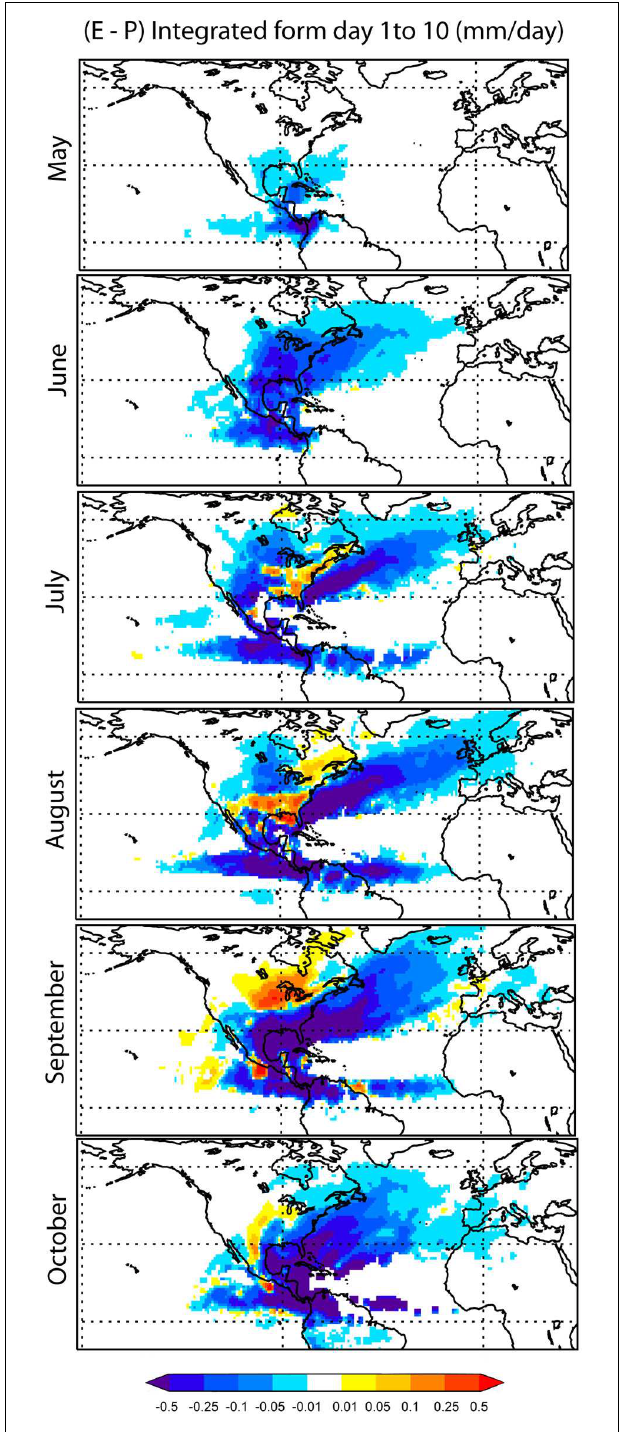
FIGURE 9 | Monthly composite differences of moisture sinks (only E − P < 0 values) between El Niño and La Niña events for 1982–1999. Units are mm d − 1